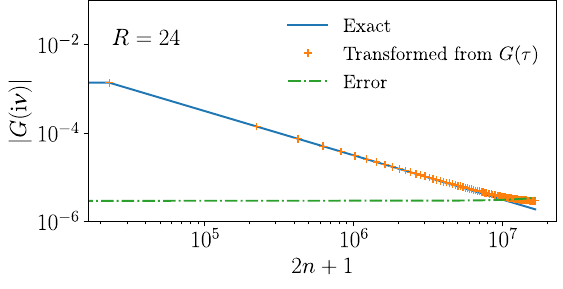
FIG. 22. Fast Fourier transform of the one-particle Green ’ s function, where G ð i ν Þ is transformed from G ð τ Þ